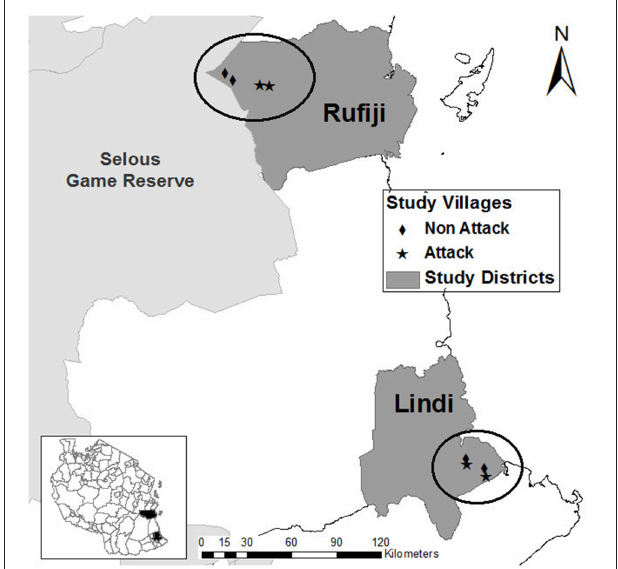
FIGURE 1 | Map of southeastern Tanzania with study districts in gray and study villages marked; circles denote areas with the highest concentration of